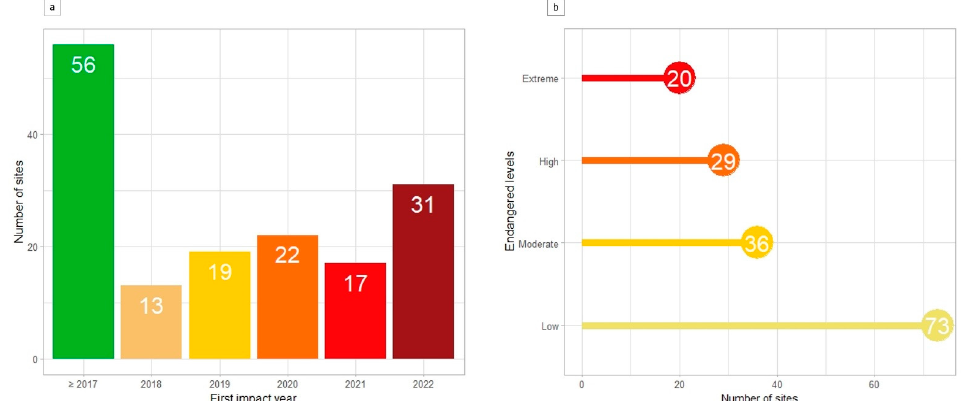
Figure 7. ( a ) Bar chart showing the first year of encroachment of endangered sites; ( b ) lollipop chart showing endangered sites, classified by the total percentage of the affected surface area.